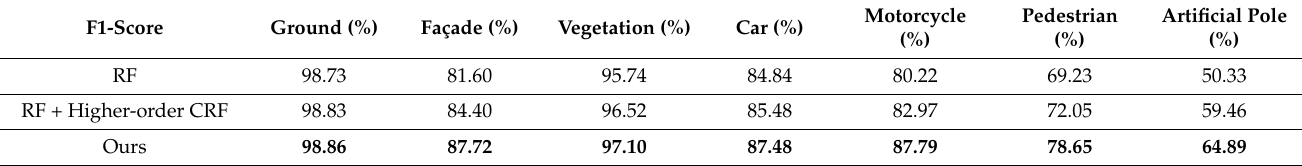
Table 12. F1-score of the proposed method in different steps in the Wuhan University dataset.